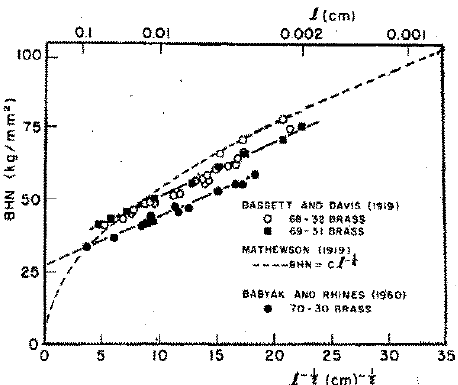
Figure 1. The Brinell Hardness Number (BHN) of alpha brass materials as a function of the reciprocal square root of polycrystalline grain size, (cid:96) − 1/2 ; see Reference [2] for references, 1.0 kg/mm 2 = 9.81